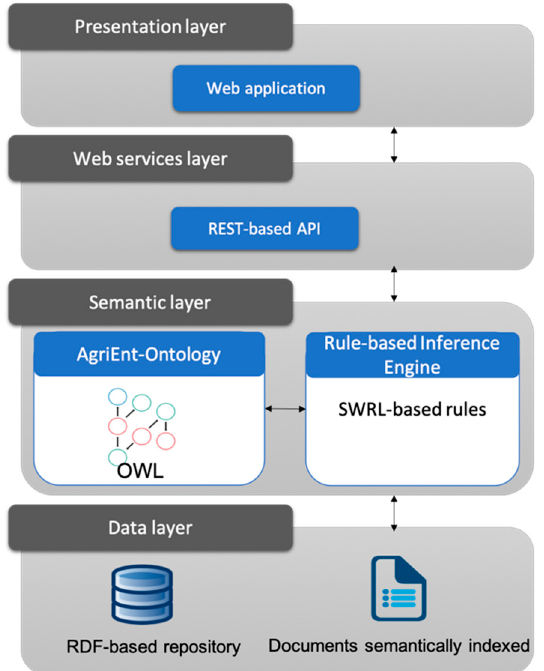
Figure 1 . General architecture of AgriEnt. Figure 1. General architecture of